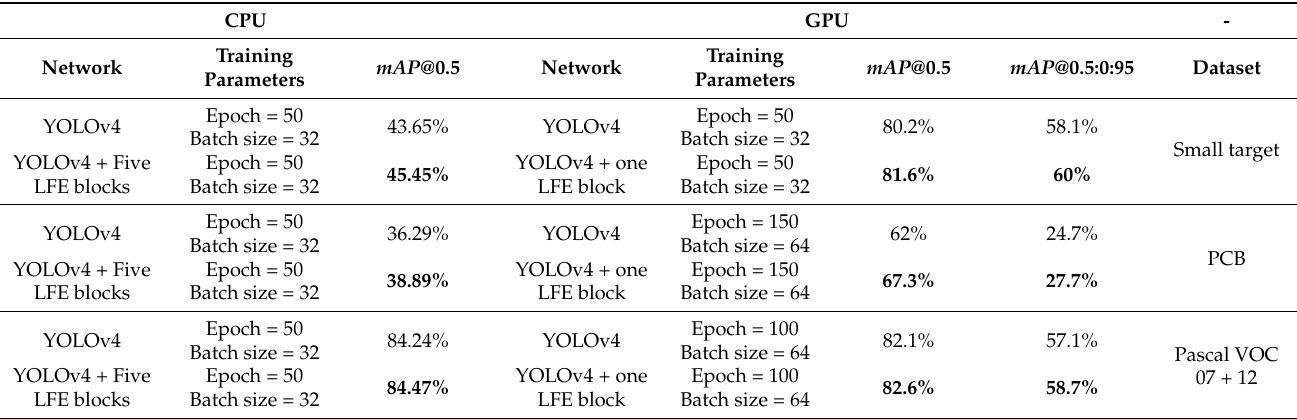
Table 2. mAP of original YOLOv4 and improved YOLOv4 in different